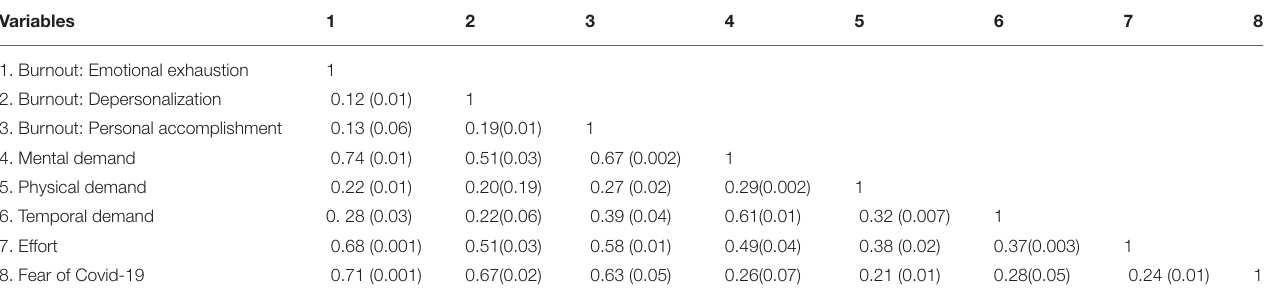
TABLE 5 | Correlations ( p -values) between emotional exhaustion, depersonalization, and personal accomplishment among studied hospital nurses.